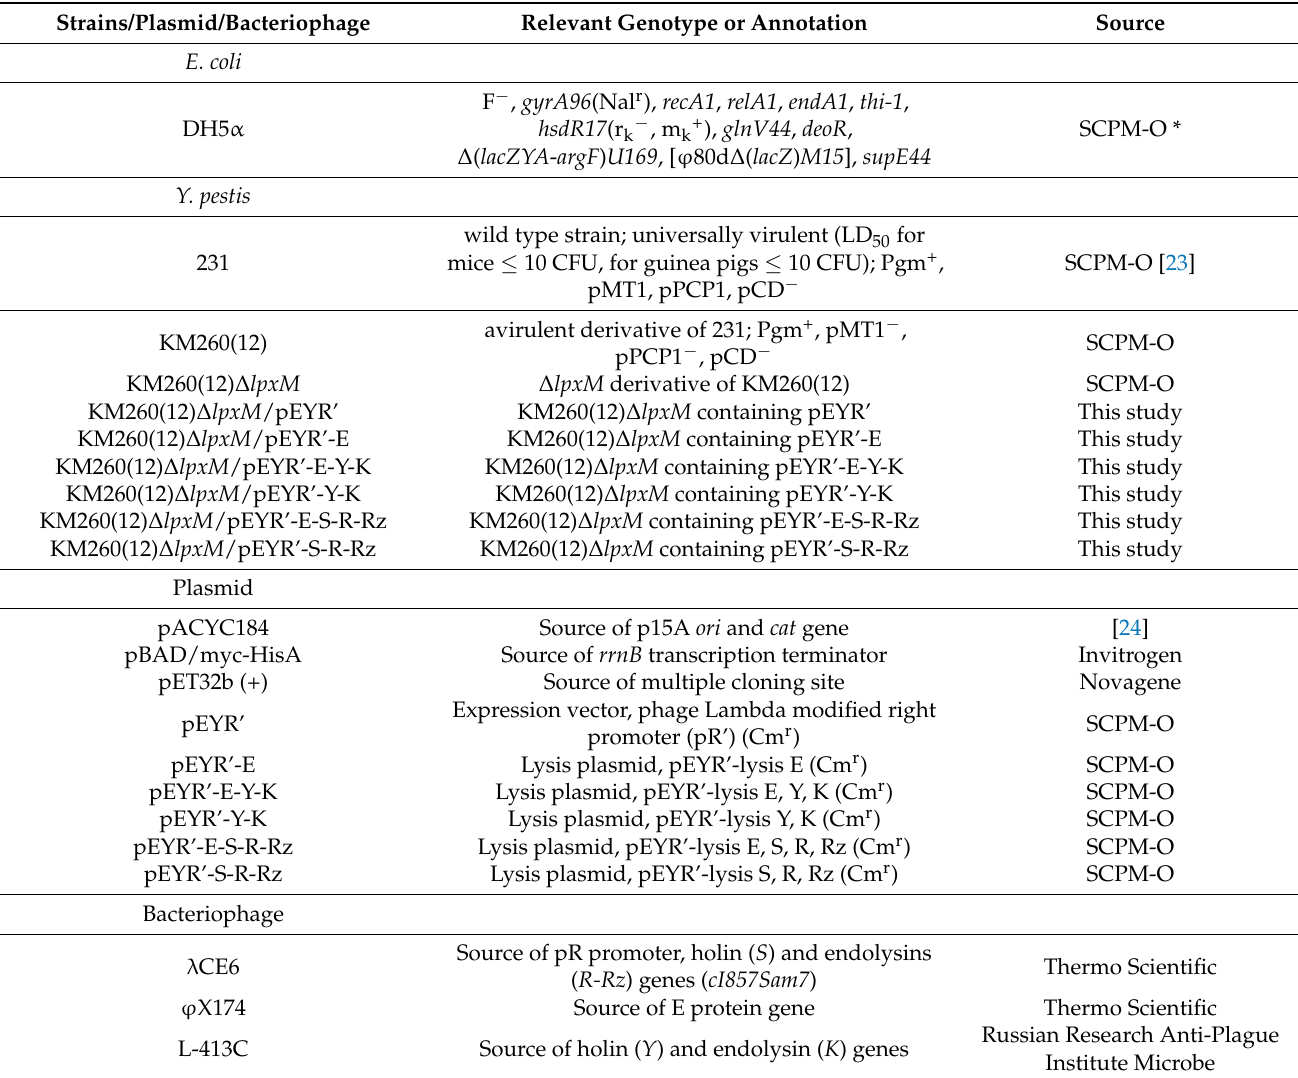
Table 1. Bacterial strains, plasmids, and bacteriophages used in this